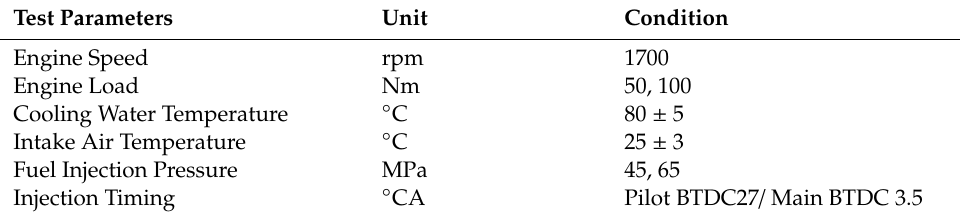
Table 2. Experiment and operating